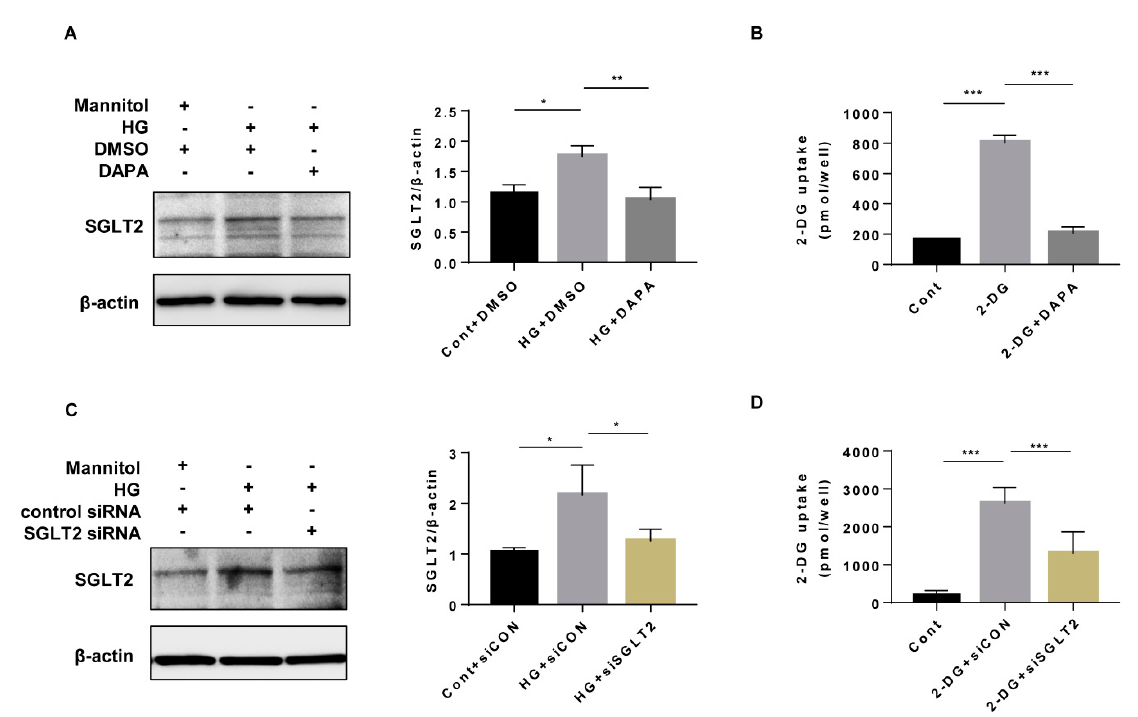
Figure 1. Dapagliflozin and SGLT2 inhibition suppressed glucose uptake in HK-2 cells. ( A ) HK-2 cells were incubated with Cont or HG (30 mM) medium and treated with or without dapagliflozin (20 µ M) for 48 h. SGLT2 was assessed by western blot densitometric evaluation (n = 3) of ( A ). ( B ) Glucose uptake analysis of 2-DG by dapagliflozin-treated HK2 cells (n = 6). ( C ) HK-2 cells were transfected with control siRNA or SGLT2 siRNA (200 nM) for 6 h and then, the medium was replaced with fresh medium with or without HG (30 mM) for 48 h. The SGLT2 level was assessed by western blotting (n = 3). ( D ) Glucose uptake analysis of 2-DG by SGLT2-knockdown HK-2 cells (n = 6). All data represent the means ± standard deviation (SD). * p < 0.05 vs. the indicated group, ** p < 0.01 vs. the indicated group, *** p < 0.001 vs. the indicated group. Cont, control; HG, high glucose; DAPA, dapagliflozin; siCON, control siRNA; and siSGLT2, SGLT2 siRNA.